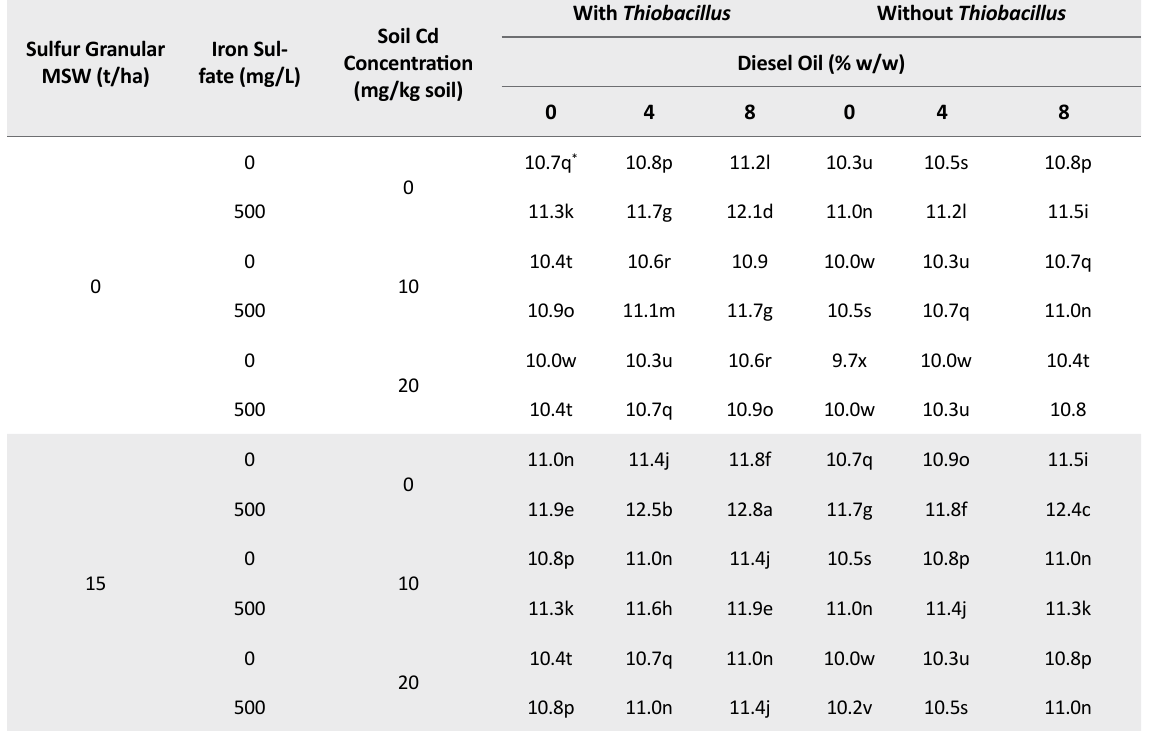
/kg soil) in the presence of thiobacillus bacteria 2